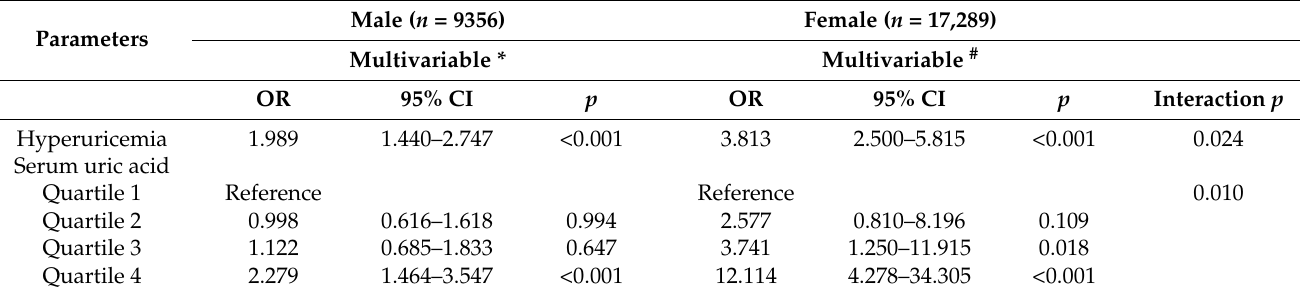
Table 4. Association of hyperuricemia and quartiles of uric acid with new-onset CKD using multi- variable logistic regression analysis in different